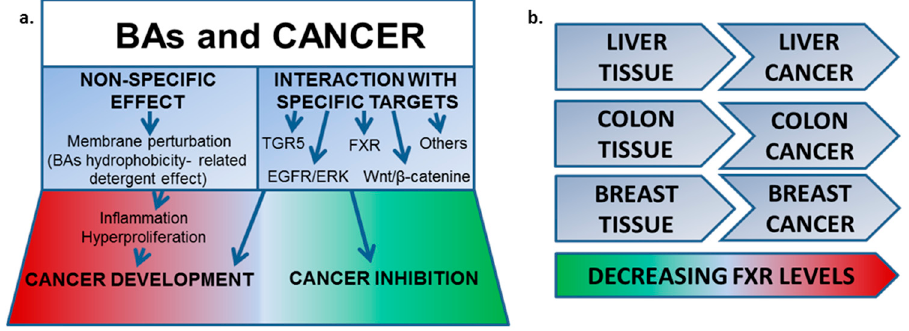
Figure 1. ( a ) Schematic summary of the involvement of BAs in cancer; ( b ) FXR expression decreases from healthy to cancer tissues.